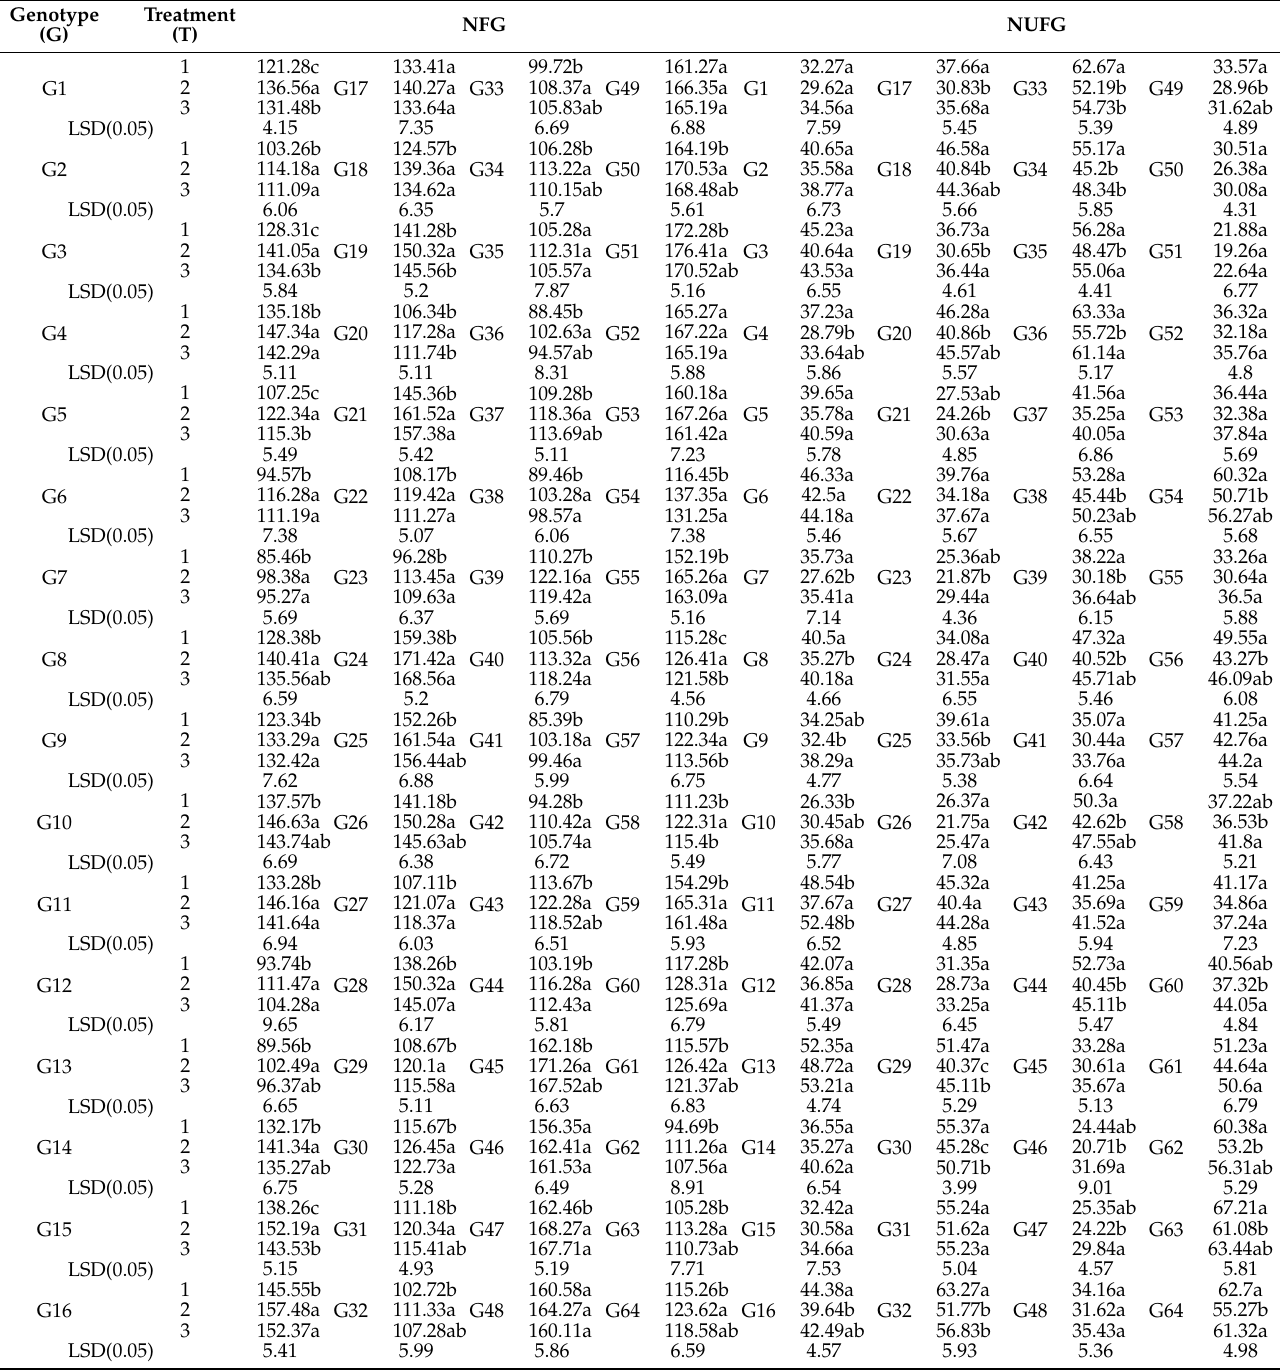
Table 8. Number of filled grains and unfilled grains per plant of 64 rice genotypes as influenced by treatment and genotype (pooled over two